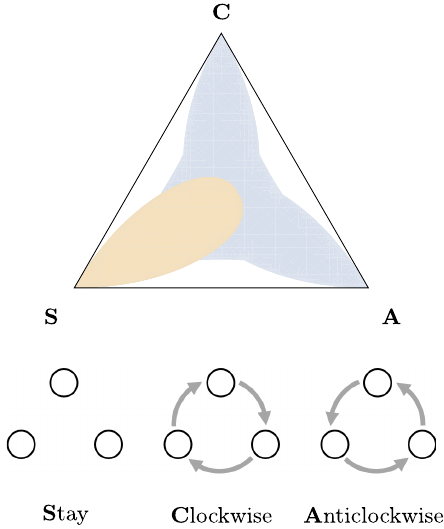
FIG. 2. Classical vs quantum memoryless processes. The vertices of the triangle correspond to deterministic processes (S, stay; C, move clockwise; A, move anticlockwise) for a random walker moving between three states. Points inside the triangle correspond to probabilistic mixtures (convex combina- tions) of these three deterministic processes; e.g., the center of the triangle corresponds to the maximally mixing dynamics (with S, C, and A each happening with probability 1 = 3 ). The orange petal-shaped region contains all stochastic processes that can arise from time-continuous, memoryless, classical dynamics. For time-continuous, memoryless, quantum dynamics, this set is enlarged by the remaining shaded region in blue. For details, see Sec. II C and, in particular, Fig.